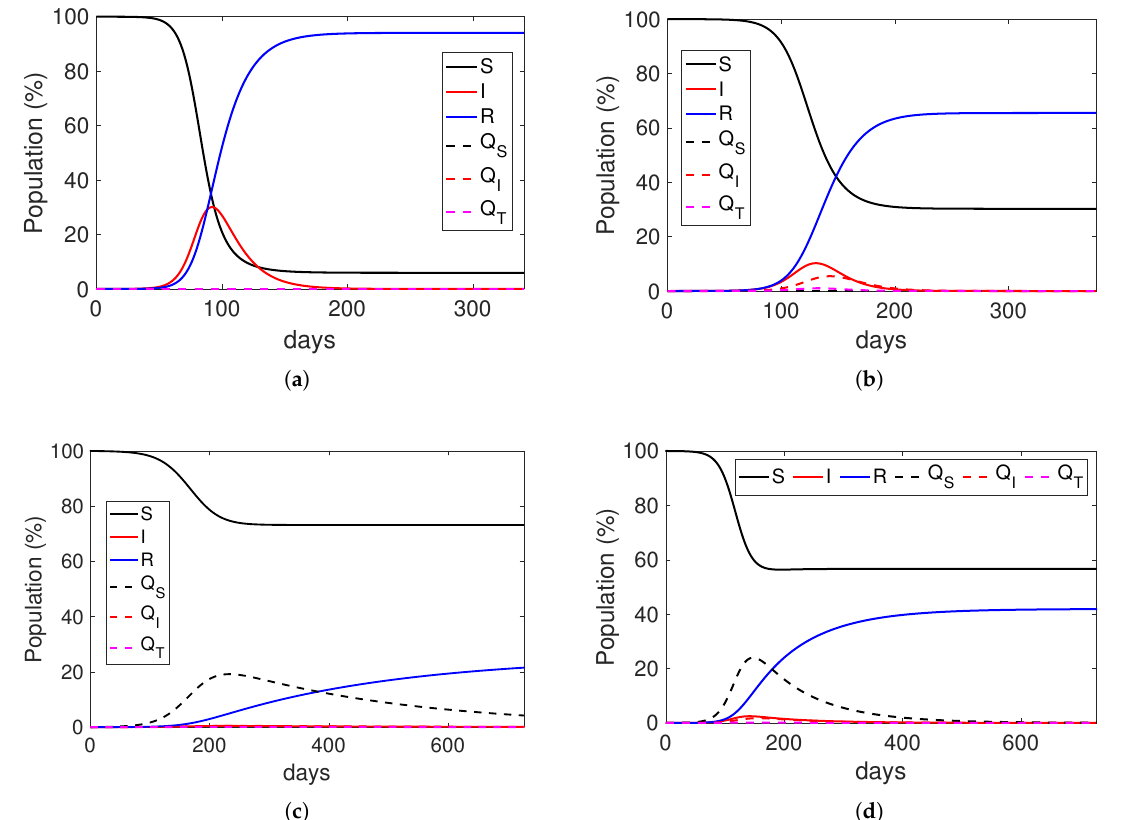
Figure 2. Epidemic dynamics with different mobile contact tracing utilization for COVID-19 infection. ( a ) No measures ( δ = q = 0); ( b ) detection and isolation of individuals, no contact tracing ( δ = 0.05, U = 0); ( c ) with mobile contact tracing (optimistic utilization) ( δ = 0.05, U = 0.7, RC = 0.8); ( d ) with mobile contact tracing (pessimistic utilization) ( δ = 0.05, U = 0.5, RC =